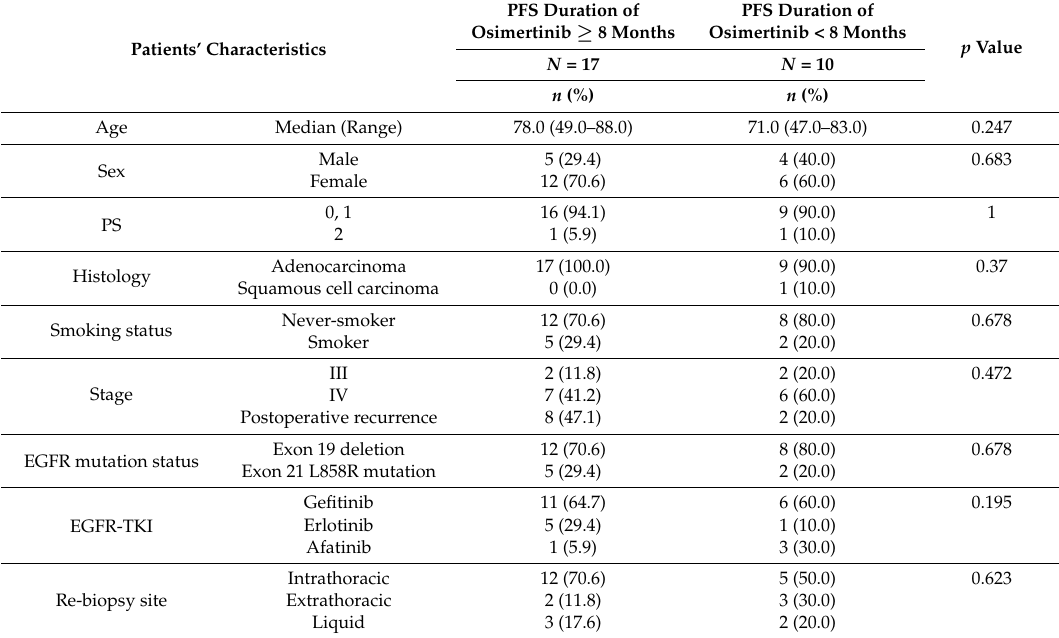
Table 2. Patients baseline characteristics classified by progression-free survival (PFS) duration of